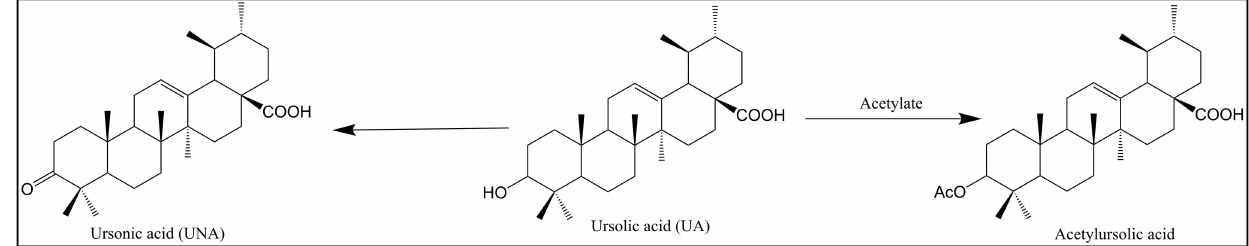
Figure 4. Chemical structures of ursonic acid (UNA), ursolic acid (UA), and acetylursolic acid. A variety of triterpenoids isolated from plants of the Schisandra family have been shown to have anti-HIV effects. The cycloartane triterpenoid lancifodilactone F ( 43 ) (Figure 2) was isolated from the leaves and stems of Schisandra lancifolia (Rehd. et Wils) A. C. Smith. Compound 43 showed anti-HIV activity with a half-maximal effective concentration (EC 50 ) of 20.69 µ g/mL and a selectivity index > 6.62 [31]. A trinorcycloartane triterpenoid, lancifodilactone H ( 44 ); an A-ring-secocycloartane triterpenoid, lancifoic acid A ( 45 ); and nigranoic acid ( 46 ) isolated from S. lancifolia can inhibit HIV, with EC 50 values of 16.6, 16.2, and 10.3 µ g/mL, respectively (Figure 2) [32]. The triterpenoid angustific acid A ( 48 ) (Figure 2), isolated from Kadsura angustifolia , exhibited inhibitory activity against HIV,